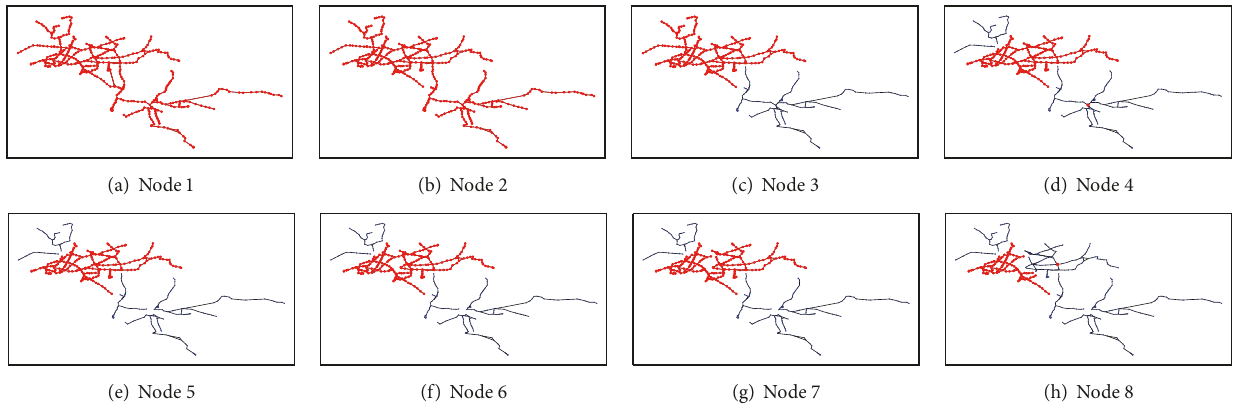
Figure 4: Evolution of an attack generation on the tram network with BETWI. The giant component is highlighted in red and bold. When attacking the 8th node, the size of the giant component is already reduced to less than 20% of the original